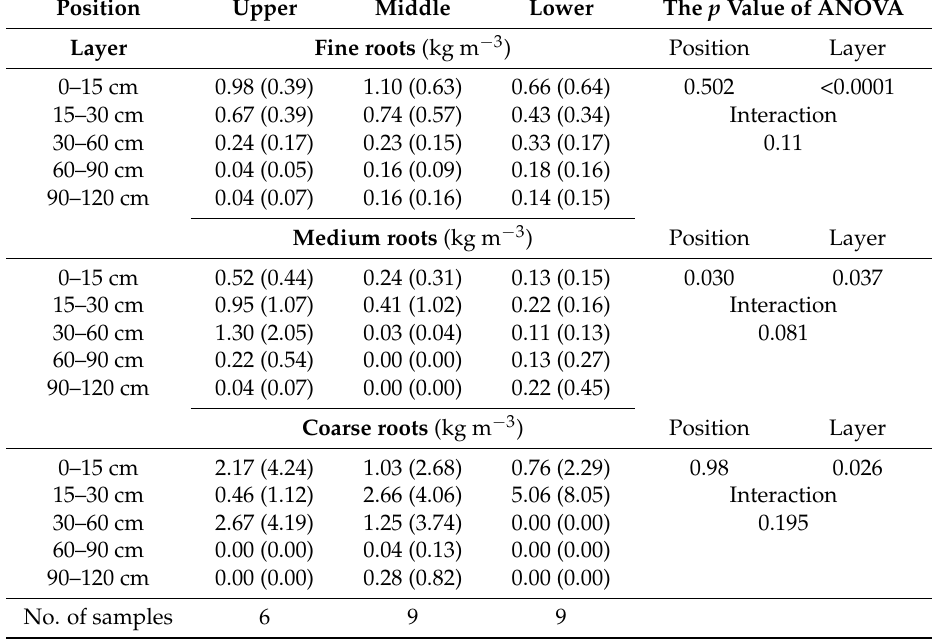
Table 2. Mean density of fine (<3 mm in diameter), medium (3–10 mm), and coarse (>10 mm) roots in the soil layers at different slope positions. Standard deviations are shown within parentheses. The p values of the two-way analysis of variance (ANOVA) test were calculated for the factors of slope position and soil layer.